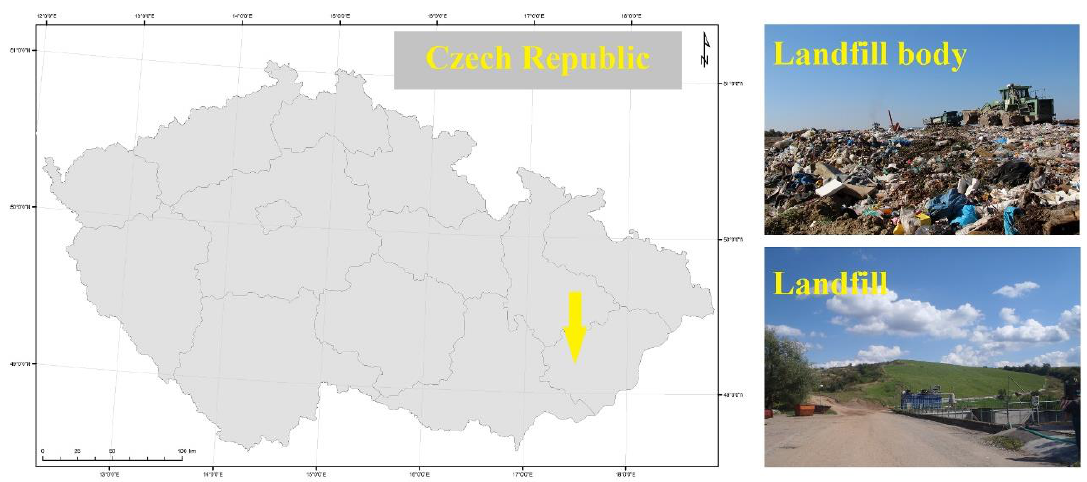
Figure 1. Scheme and aerial photograph (insert) of the landfill site.